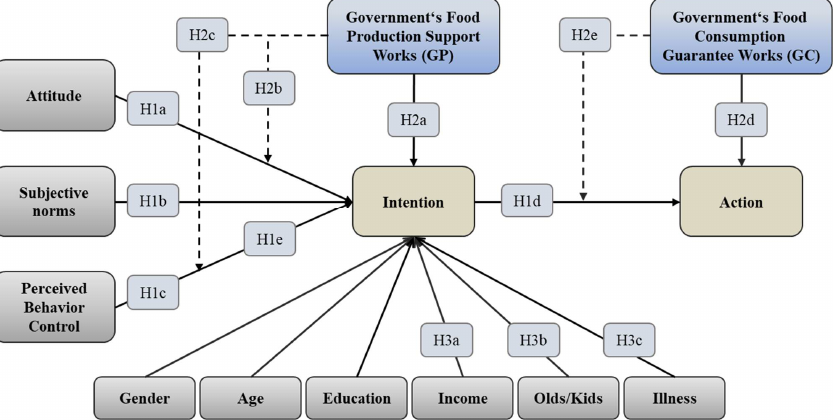
Figure 1. Schematic diagram of SEM model with the moderating effect of satisfaction with gov- ernment regulation.